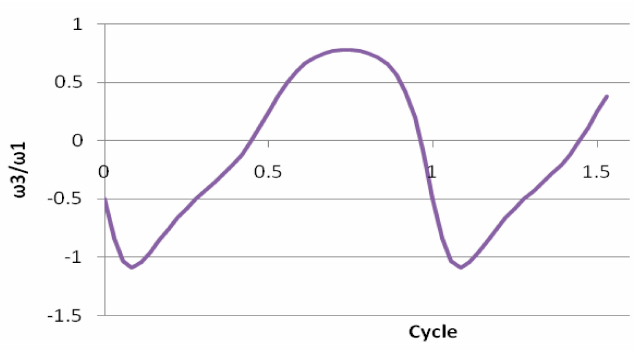
Figure 10. The schematic sweep movement of the crank.